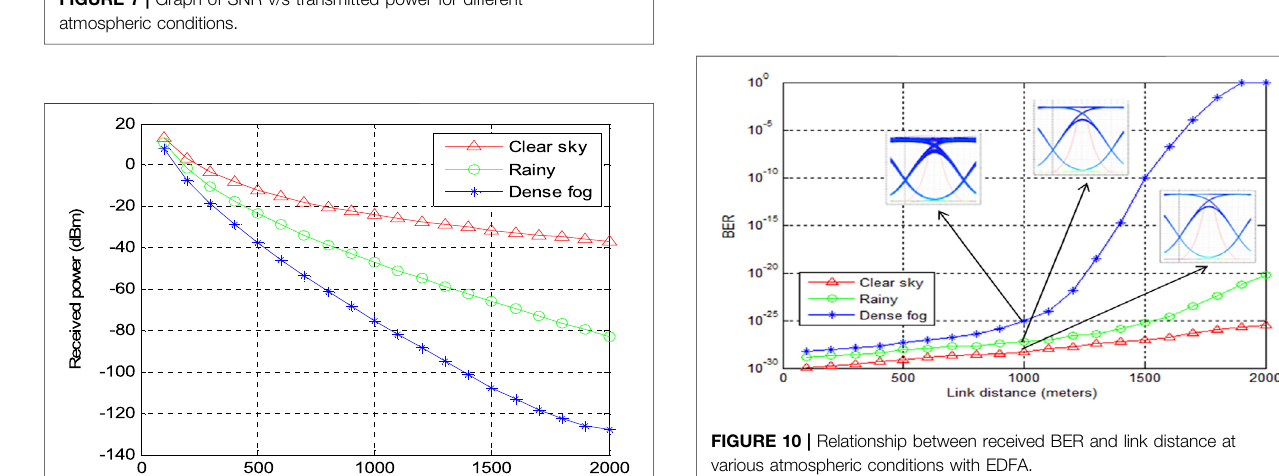
Figure 8 highlights the relation between received signal power and link distance for different meteorological conditions. It can